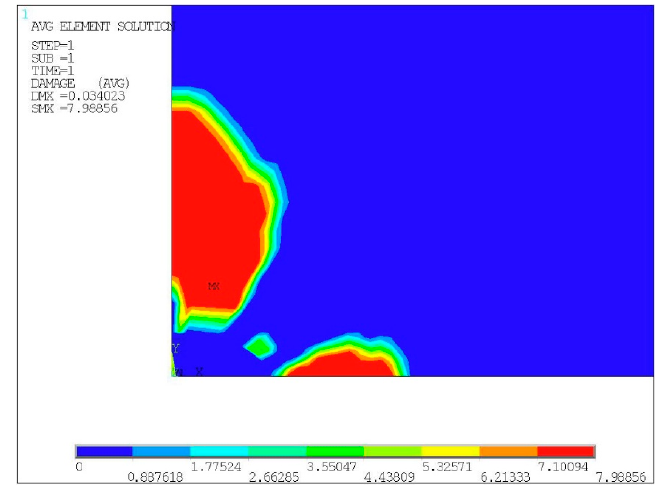
Figure 13. Damage cloud chart of specimen No. 53.